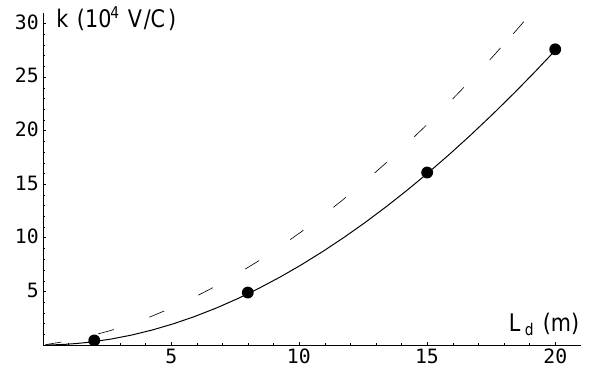
FIG. 3. Loss factor k as a function of the length of the perforated beam screen L d (for a device length L d much longer than the attenuation length L a (cid:6) 80 m). The solid line refers to Eq. (17) and the dots give the exact numerical values from Eq. (8). The dashed line is obtained neglecting backward wave. We use the following parameters: b (cid:1) 19 mm, d (cid:1) 24.5 mm, r b (cid:1) r d (cid:1) 7.1 3 10 2 7 V (cid:1) m, D (cid:1) 16 mm, s (cid:1) 75 mm, rounded end slots 8 mm 3 1.5